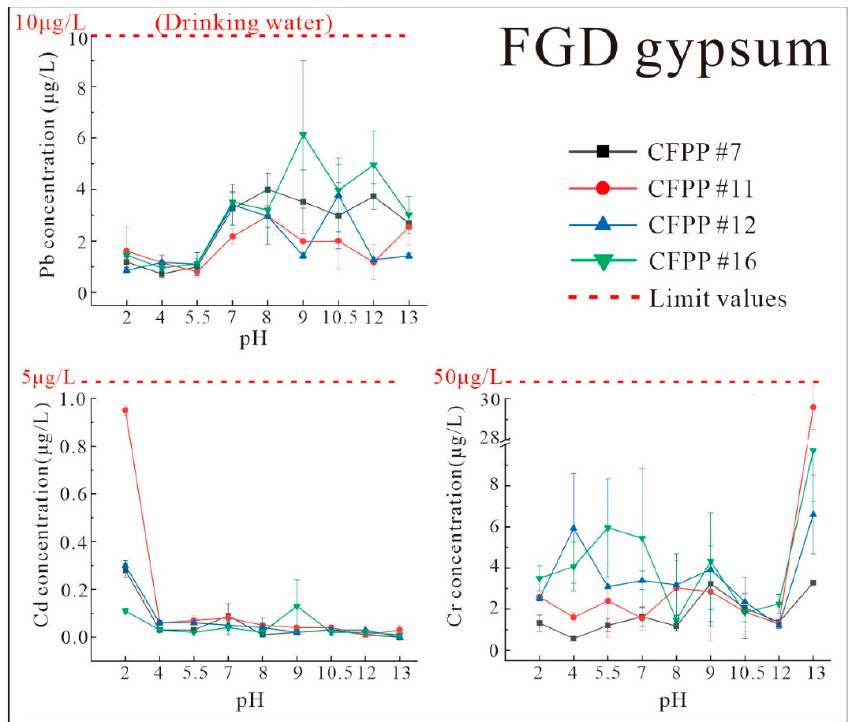
Figure 6. Characteristics of heavy metals leaching from FGD gypsum at various pH values and a constant solid–liquid ratio of 1:10 (The dashed lines indicate the pollution concentration limits for the different standards.).